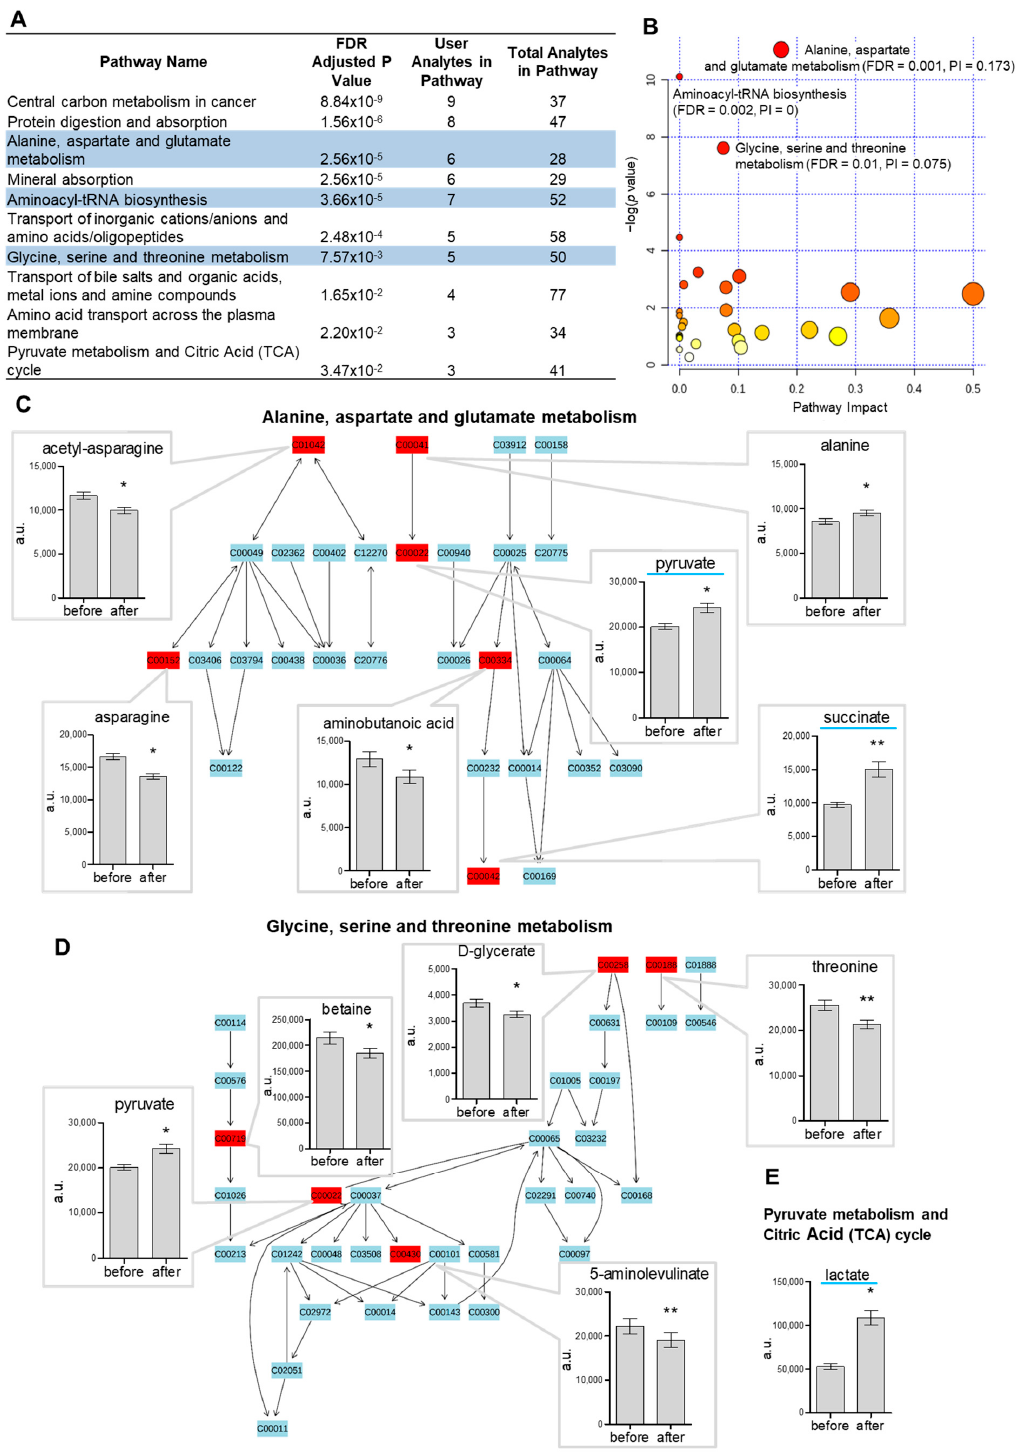
Figure 3. The pathway analysis of metabolome using ( A ) RaMP showing overlapping results (blue-highlighted pathways) with the analysis from ( B ) Metaboanalyst, where the 3 significantly represented pathways (FDR < 0.05) are identified, and ( C – E ) the top pathways are shown in detail, with the significantly regulated metabolites in plasma before/after ice-water swimming shown in bar plots (mean ± SD), * p < 0.05/** p < 0.01 analyzed by Wilcoxon matched pairs signed-rank test with Benjamini-Hochberg correction. ( C ) Alanine, aspartate and glutamate metabolism pathway, ( D ) glycine, serine and threonine metabolism pathway and ( E ) pyruvate metabolism and citric acid (TCA) cycle, where the remaining regulated metabolites pyruvate and succinate are shown in ( C ), highlighted in blue. PI—pathway impact